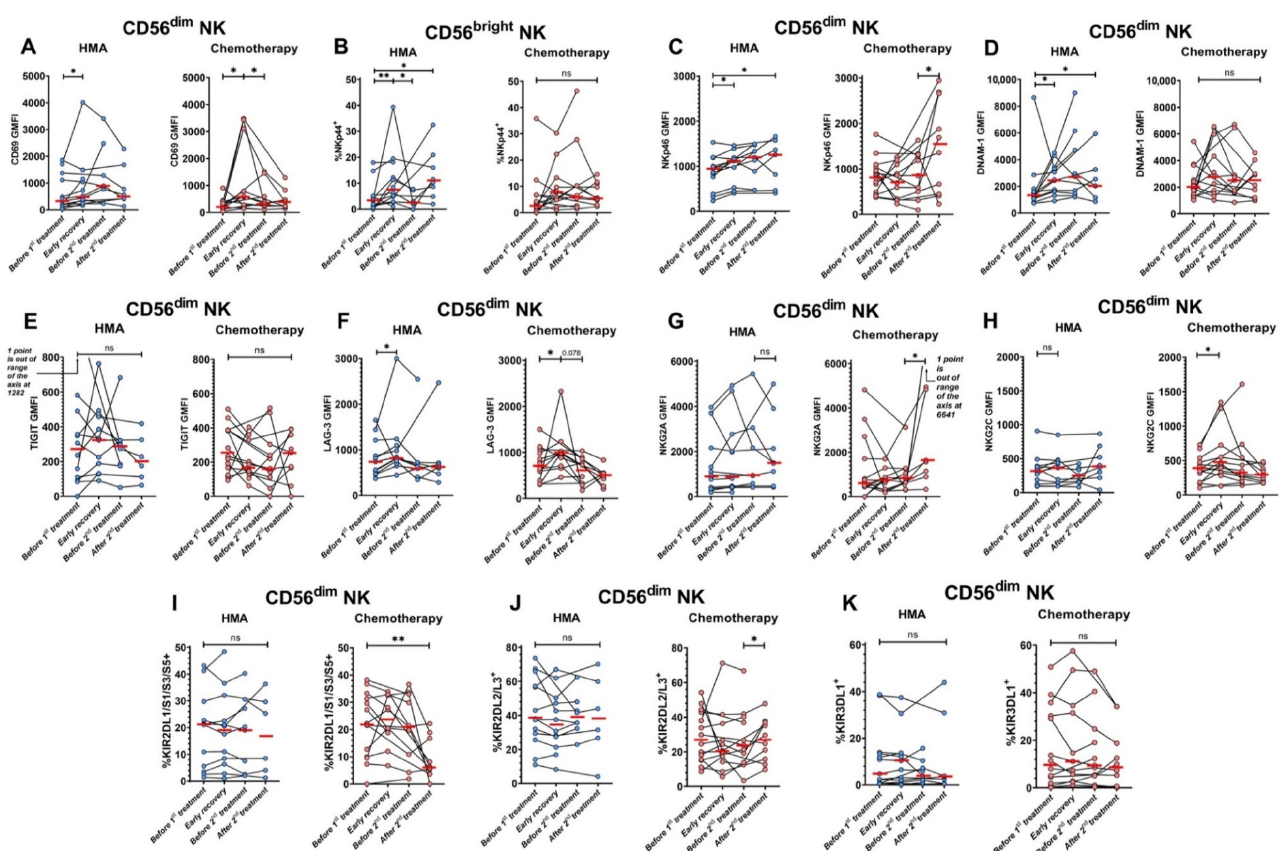
Figure 6. Expression levels of various NK cell surface receptors before and after HMA/venetoclax and cytotoxic therapies. Blue circles are HMA/venetoclax (left panels), pink circles are chemotherapy (right panels), and red bars represent medians. Data are from patients with >1 sample collected. ( A ) CD69 expression on mature CD56 dim NK cells. ( B ) Percent of NKp44 + immature CD56 bright NK cells. ( C ) NKp46 expression on mature CD56 dim NK cells. ( D ) DNAM-1 expression on mature CD56 dim NK cells. ( E ) TIGIT expression on mature CD56 dim NK cells. ( F ) LAG-3 expression on mature CD56 dim NK cells. ( G ) NKG2A expression on mature CD56 dim NK cells. ( H ) NKG2C expression on mature CD56 dim NK cells. ( I ) Change in % CD56 dim NK cells expressing KIR2DL1/S1/S3/S5. ( J ) Change in % CD56 dim NK cells expressing KIR2DL2/L3. ( K ) Change in % CD56 dim NK cells expressing KIR3DL1. Wilcoxon signed-rank test was used for statistical analysis. ns— p > 0.05; *— p < 0.05; **— p < 0.01. A p-value is specified in cases when it is close to